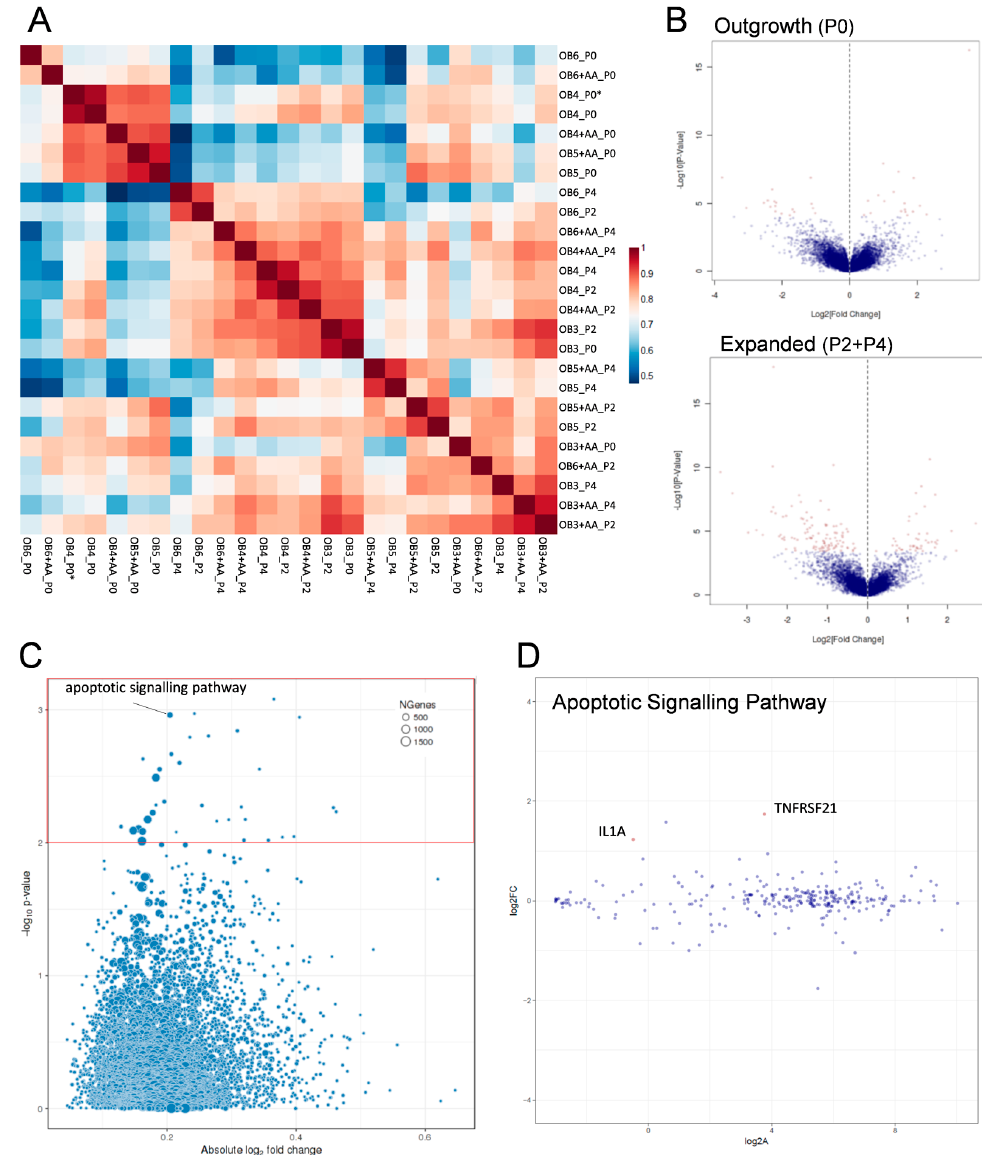
Figure 5. Transcriptomic analysis. The effect of AA on the mRNA expression profiles of osteoarthritic OB was assessed by RNAseq in the absence and presence (+AA) of AA following outgrowth (P0) and expansion (P2, P4) for n = 4 donors. ( A ) Gene expression heat maps for each donor (donors OB3, OB4, OB5, and OB6) at different time points in the absence or presence of AA (+AA) are depicted with the color scheme shown on the right; * indicates a replicate sample from the same donor (donor 4, OB4_P0). ( B ) Volcano plot visualising the differentially expressed genes in outgrowing OB (corresponding to P0 cells, upper plot) and expanded OB (including P2 and P4 OB, lower plot). Red dots depict significantly differentially expressed genes between OB cultured with AA as compared to OB in CM. ( C ) The main pathways affected by AA supplementation in expanded OB, as identified by GO GeneSet downstream analyses, are shown in this scatter plot, with the most affected ones included within the red box ( p < 0.01). ( D ) Gene expression of members of a selected pathway, the apoptotic signalling pathway (indicated in C ), showing the distribution of genes regulated in the presence of AA.